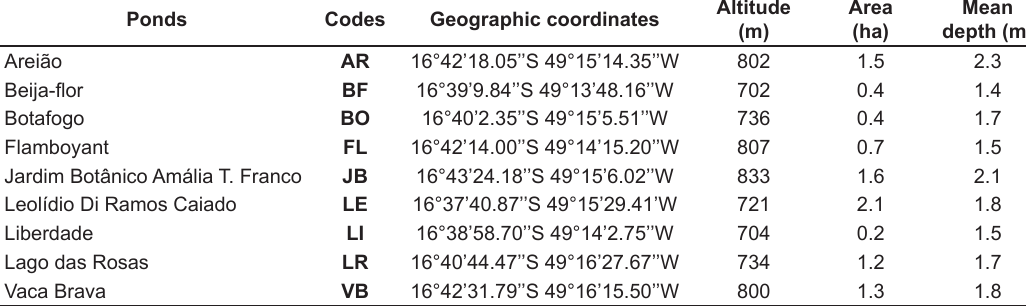
Jardim Botânico Amália T.